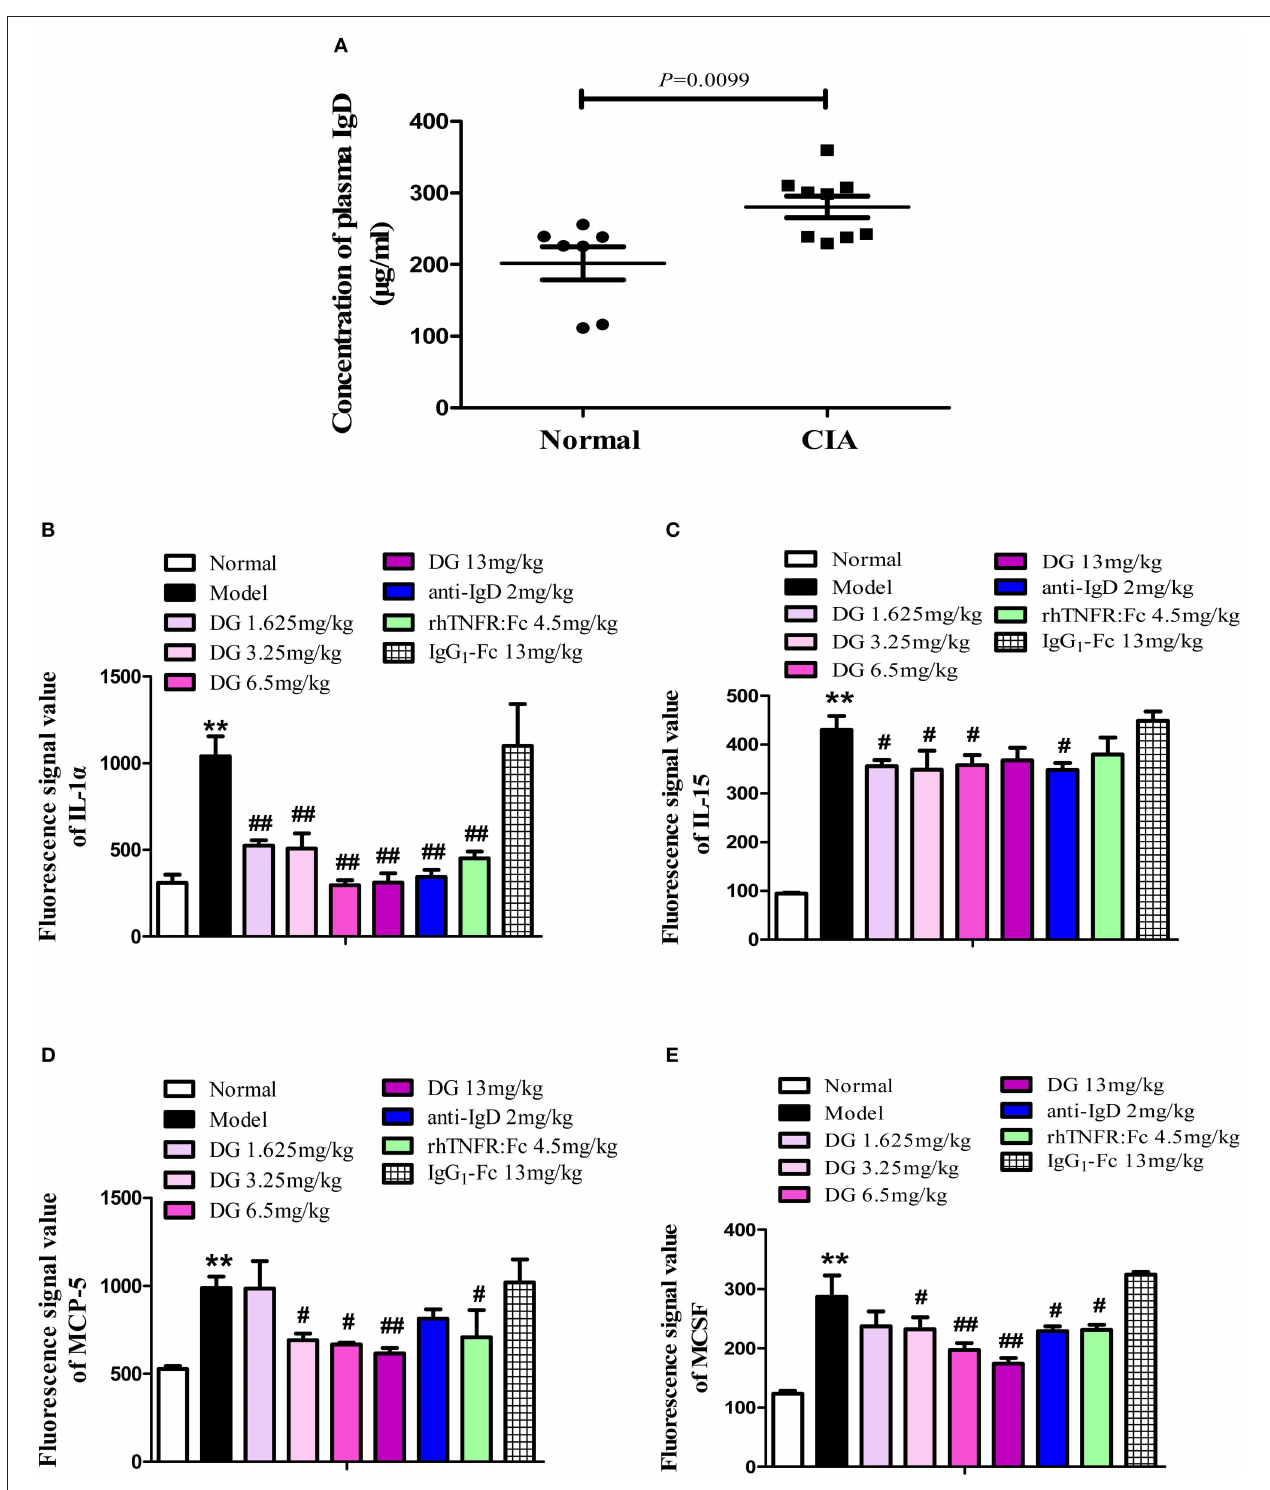
FIGURE 8 | Effects of IgD-Fc-Ig (DG) on IgD levels, cytokines, and chemokines function of CIA mice. Effects of IgD-Fc-Ig on the plasma levels of sIgD (A) and secretion of IL-1 α (B) , IL-15 (C) , MCP-5 (D) , and MCSF (E) . Data were expressed as mean ± SEM (For each group 4–6 mice). ** P < 0.01 v s. Normal, # P < 0.05 and ## P < 0.01 vs.